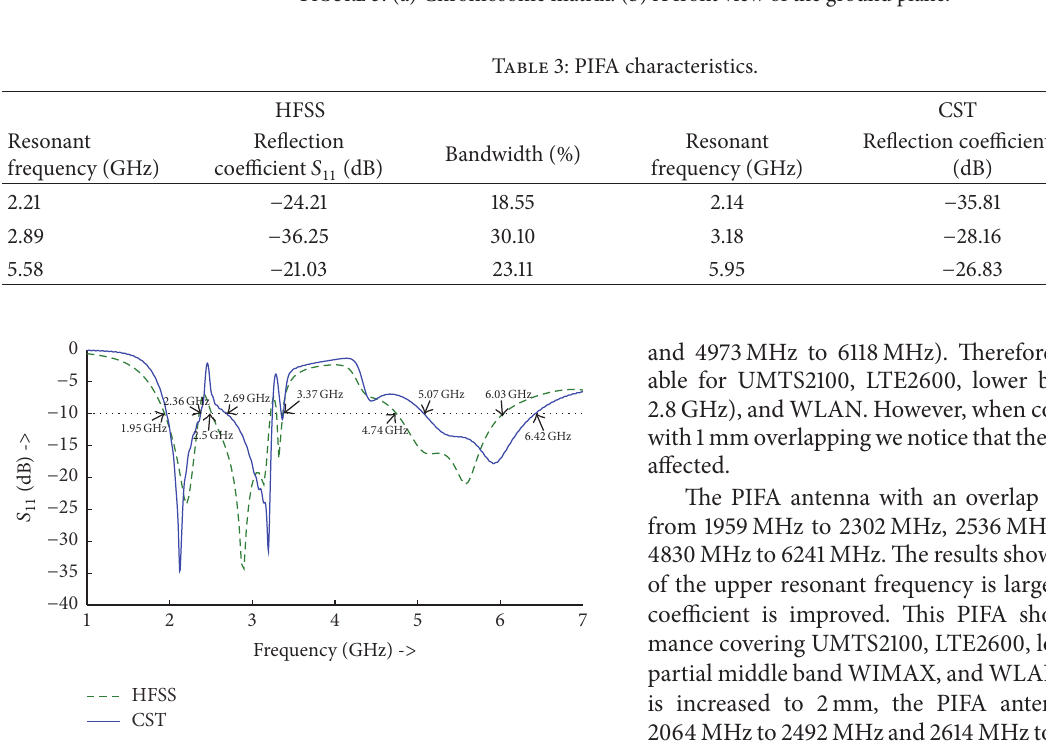
Figure 4: Simulated reflection coefficient (HFSS and